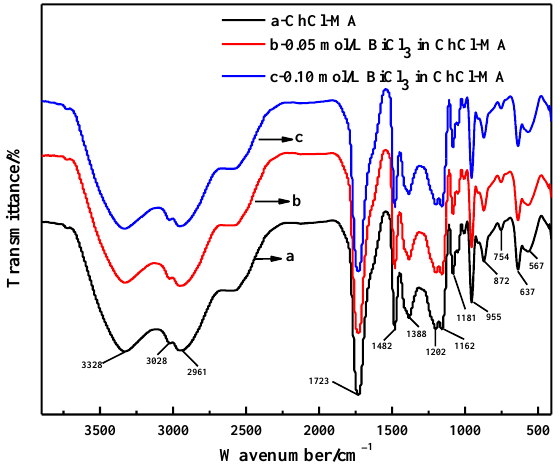
Figure 2. FTIR spectra of ChCl-MA system and ChCl-MA-BiCl 3 . Figure 3 shows the Raman spectra of ChCl-MA and the electrolyte containing different concentrations of Bi(III). The sharper band at 719 cm − 1 is attributed to the symmetrical stretching vibration of the four C-N bonds ( ν 1 ) in the choline group. The bands at 865 cm − 1 and 954 cm − 1 are attributed to the symmetric ( ν 2 ) and asymmetric ( ν 3 , ν 4 ) stretching vibrations of the C–N bond, respectively. The weaker band at 768 cm − 1 is due to the symmetrical tensile vibration of the four C–N bonds ( ν 1 ) in the trans-configuration of the choline group O–C–C–N + backbone [18]. The band at 1437 cm − 1 is due to the bending vibration of the –OH bond. The bands at 2961 cm − 1 and 3031 cm − 1 are caused by the stretching vibration of C–H [19]. The band at 1728 cm − 1 is attributed to the stretching vibration of the C=O bond in the –COOH group [20].